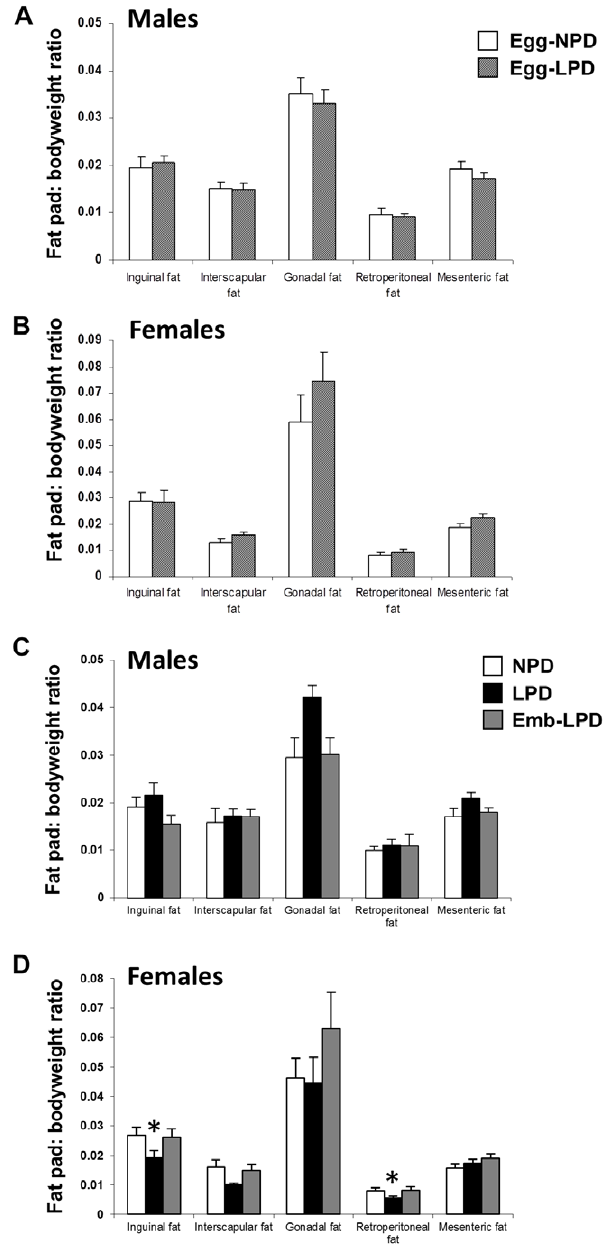
Figure 4. Mean offspring fat pad: body weight ratios. Mean fat pad: body weight ratio from (A) male or (B) female offspring fed NPD or LPD exclusively during oocyte maturation (Egg-NPD and Egg-LPD respectively), or (C) male or (D) female offspring fed NPD or LPD throughout gestation, or LPD exclusively during preimplantation development (Emb-LPD). Values are means for 9–13, 11–12, 9–12, 8– 10 and 9–11 Egg-NPD, Egg-LPD, NPD, LPD and Emb-LPD males and females respectively 6 SEM; *P ,